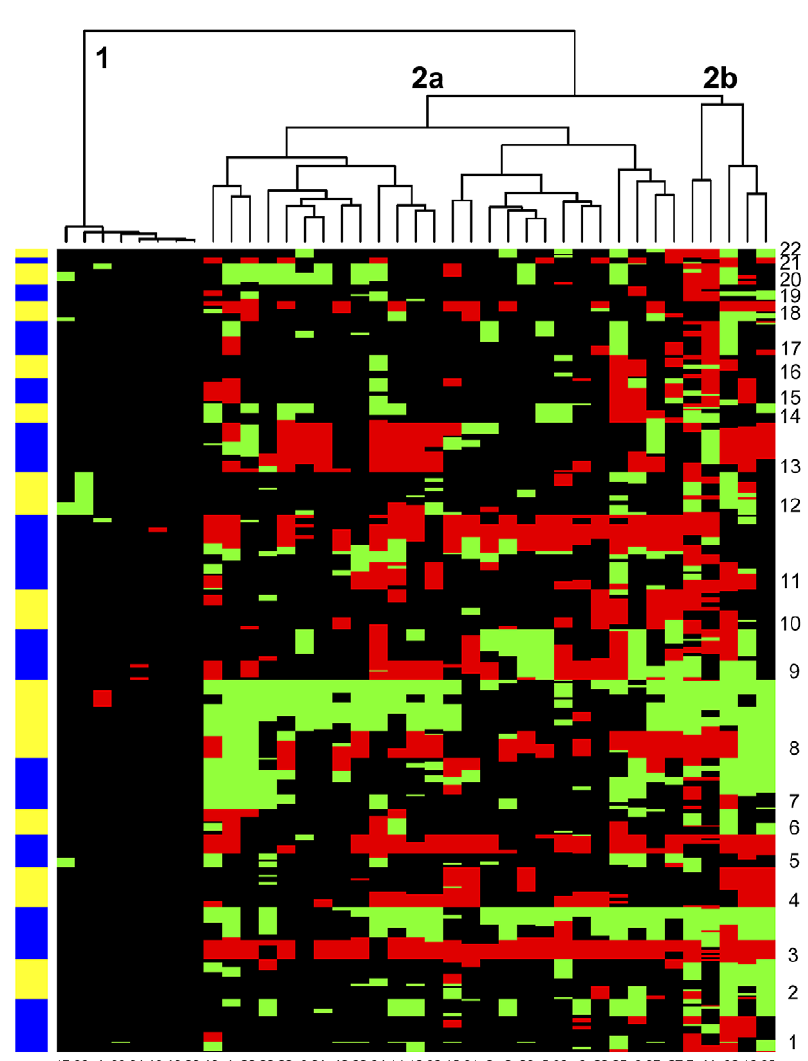
Fig. 1. WECCA heatmap of 39 OOSCCs without HPV involvement. At the top of the tree two tumor groups can be distinguished: a group consisting of 8 OOSCC with in general genetically silent profiles and another group of 31 tumor with many genetic aberrations. In group 2 downwards, two subgroups (a and b) can be distinguished with 2b as the group with the most genetic aberrations. The x -axis represents tumor numbers and the y -axis chromosome